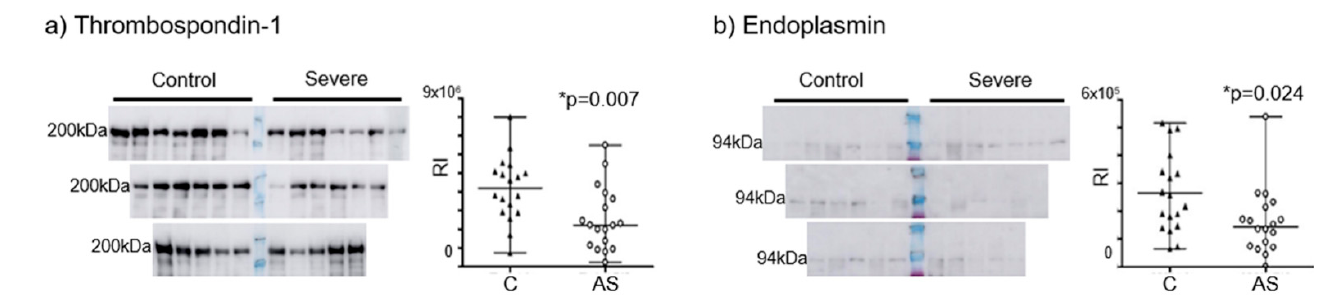
Figure 3. Western blot confirmation of thrombospondin-1 ( a ) and endoplasmin ( b ) levels in the plasma samples (control and severe AS subjects), with the corresponding p -values (Student’s t -test) for each protein analyzed: *= p < 0.05; RI, relative intensity.